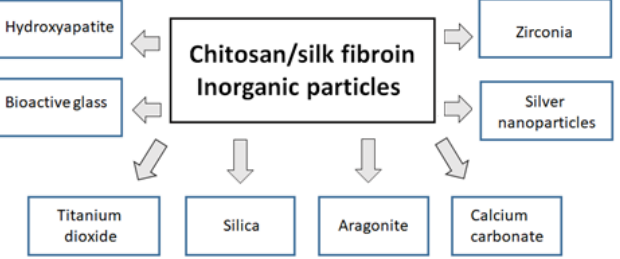
Figure 8. The examples of inorganic particles to be used in preparation of composites based on a blend of chitosan and silk fibroin.